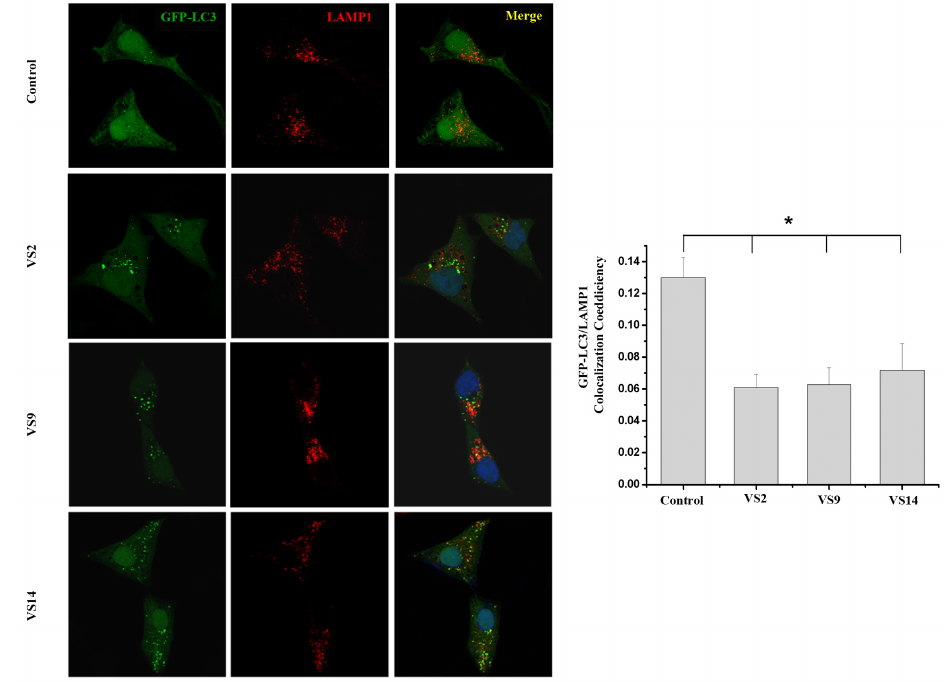
Figure 3. Vacuolin-1 analogues (10 µM) markedly induced GFP-LC3B-II puncta in HeLa cells, which were not colocalized with RFP-LAMP1. Scale bar = 10 µm. *, paired t -test, p < 0.05 compared to control group.